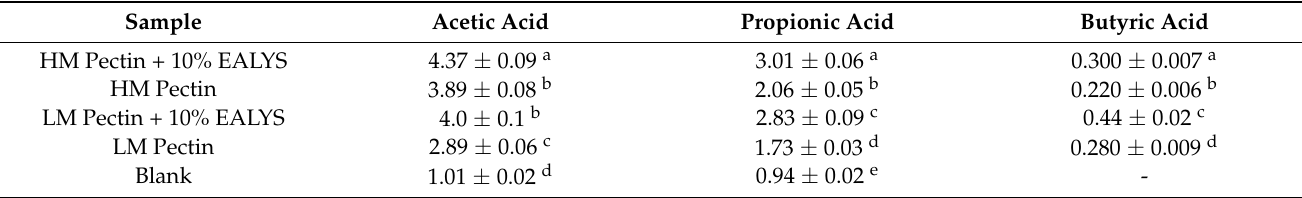
Table 1. Prebiotic activity of pectin films measured as release of short chain fatty acids (SCFAs) (mmol/g of sample) 1,2 . Sample Acetic Acid Propionic Acid Butyric Acid HM Pectin + 10%